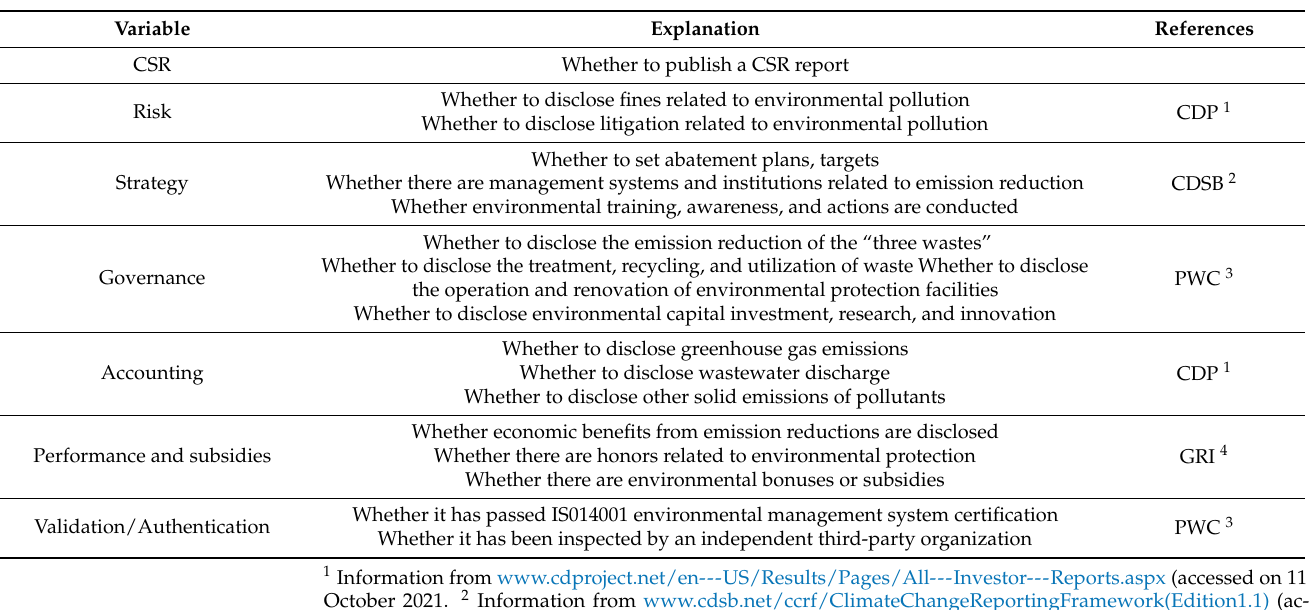
Table 1. Content of carbon information